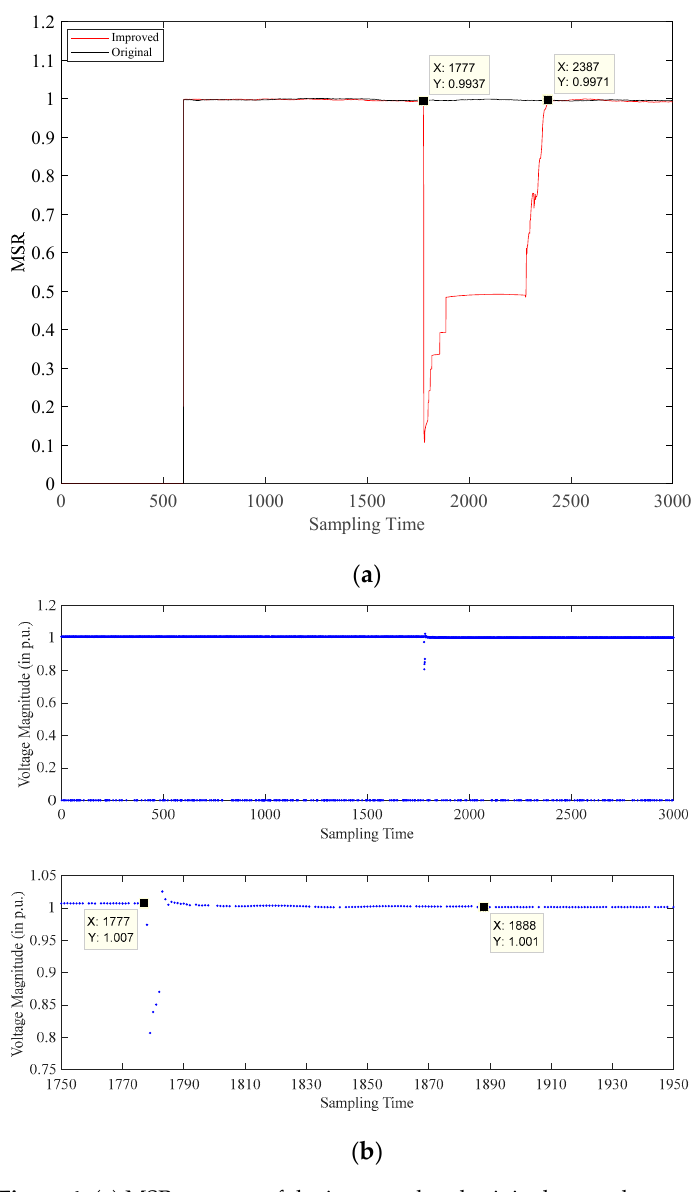
Figure 4. ( a ) MSR-t curves of the improved and original event detectors, ( b ) voltage magnitude of a certain PMU, event detection using voltage magnitudes of real PMU data.